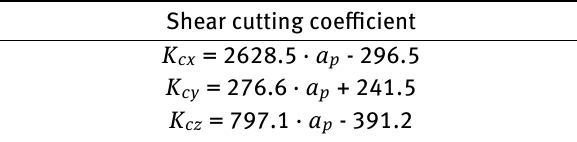
Figure 6: Force prediction neglecting the wear